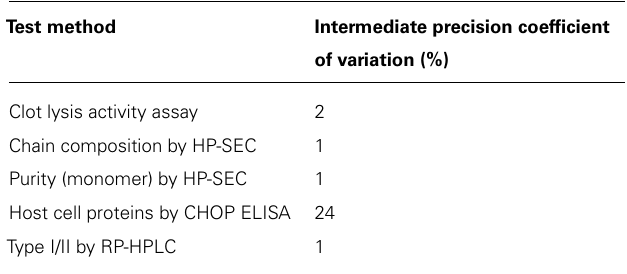
Table 1 | Method validation for Boehringer Ingelheim Metalyse release